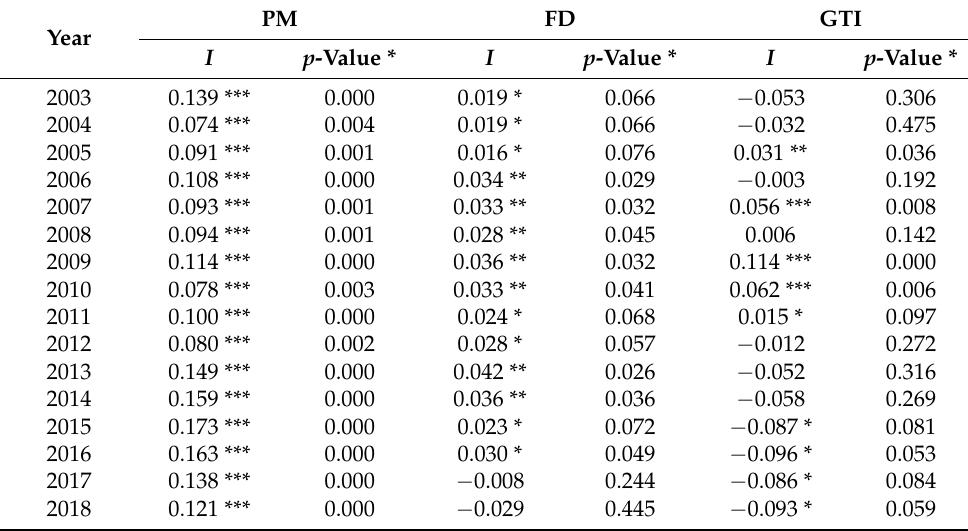
Table 2. Moran’s I index of core